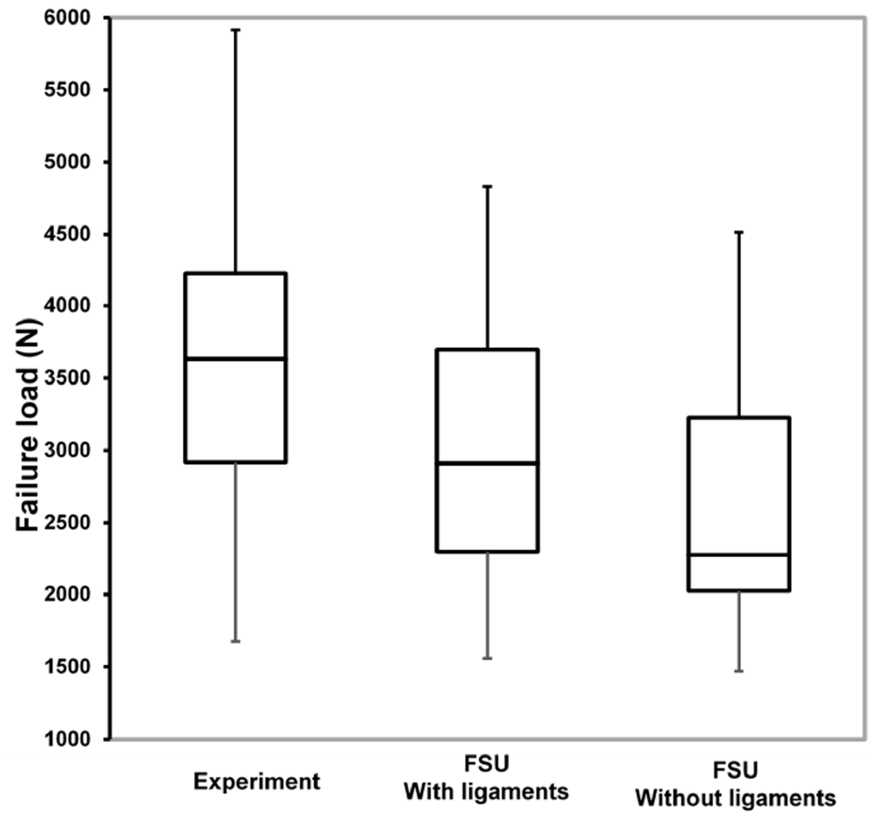
Figure 4. The failure load comparison box plots between the experimental, FSU with ligaments, and FSU without ligaments models.